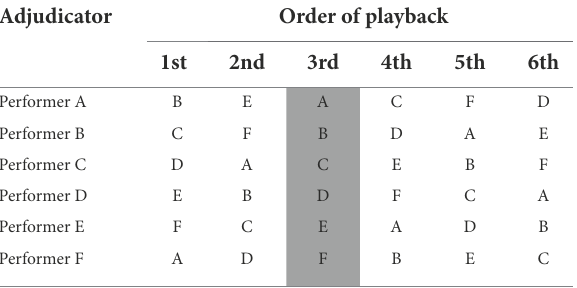
TABLE 1 The order of playback at the third session.